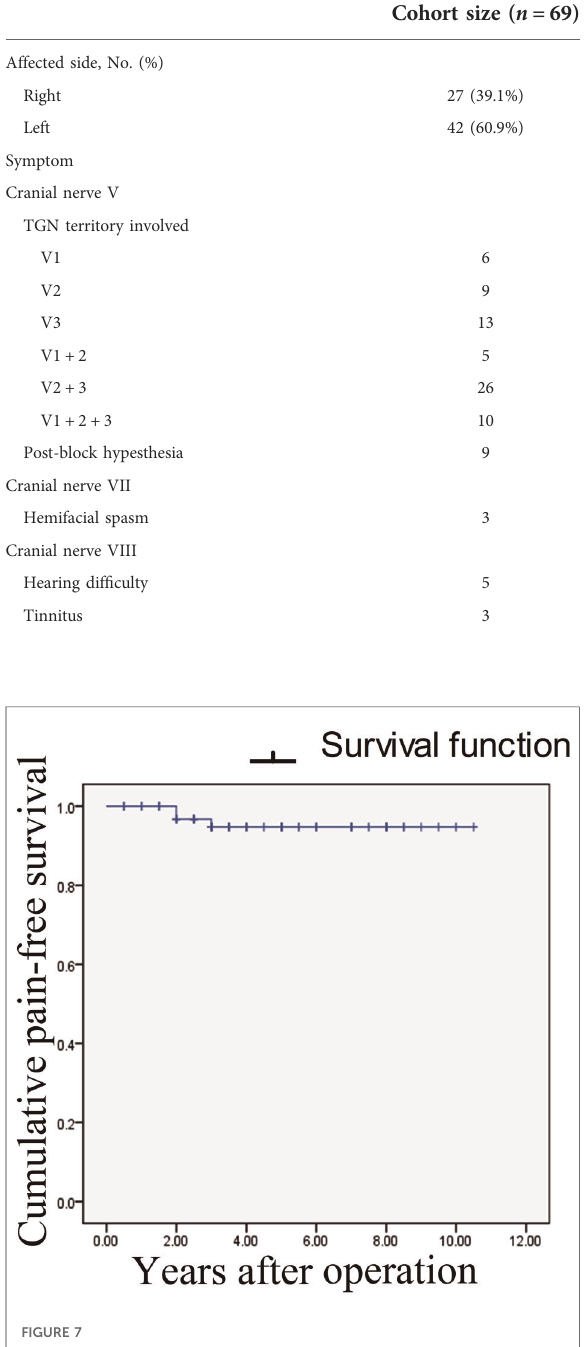
TABLE 2 Different types of TN involvement and the occurrence of related CN complications and surgical outcomes.